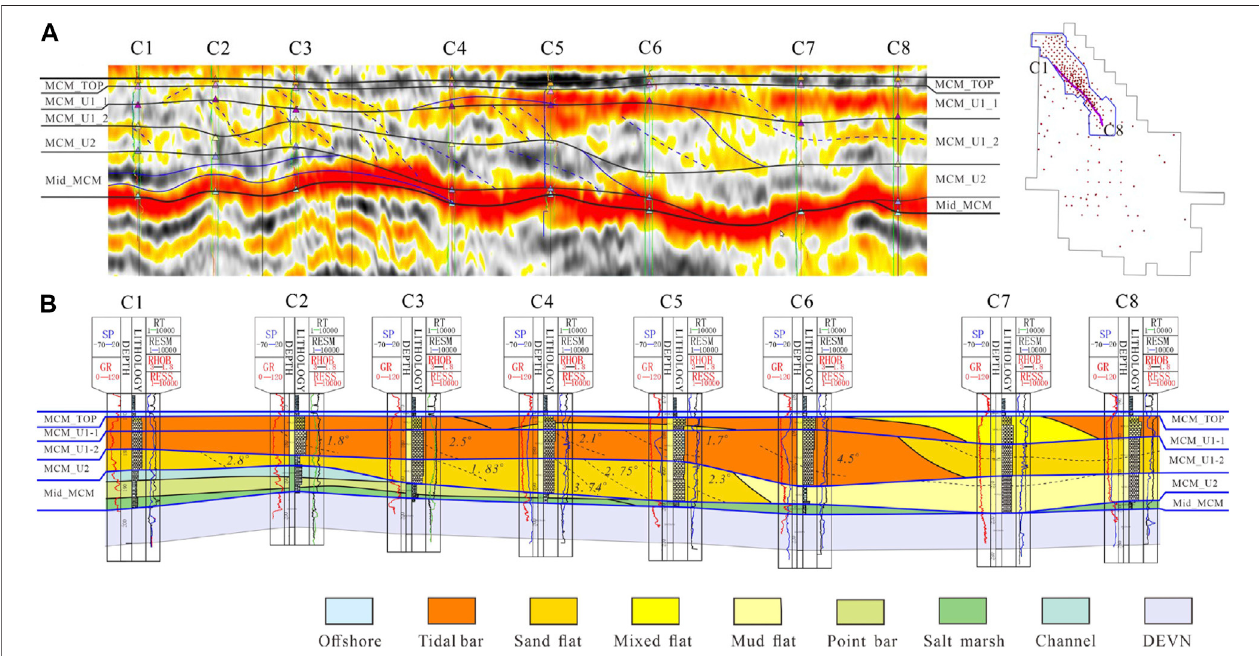
FIGURE 6 | (A) The left one is 2D seismic pro fi le of the cross-section in the provenance direction, the Gr curve on the right side of the loggingcurve, and the RESS curve on the left side. The right one is the location of the pro fi le. (B) Architecture element analysis of the connected well pro fi le in the direction of vertical provenance